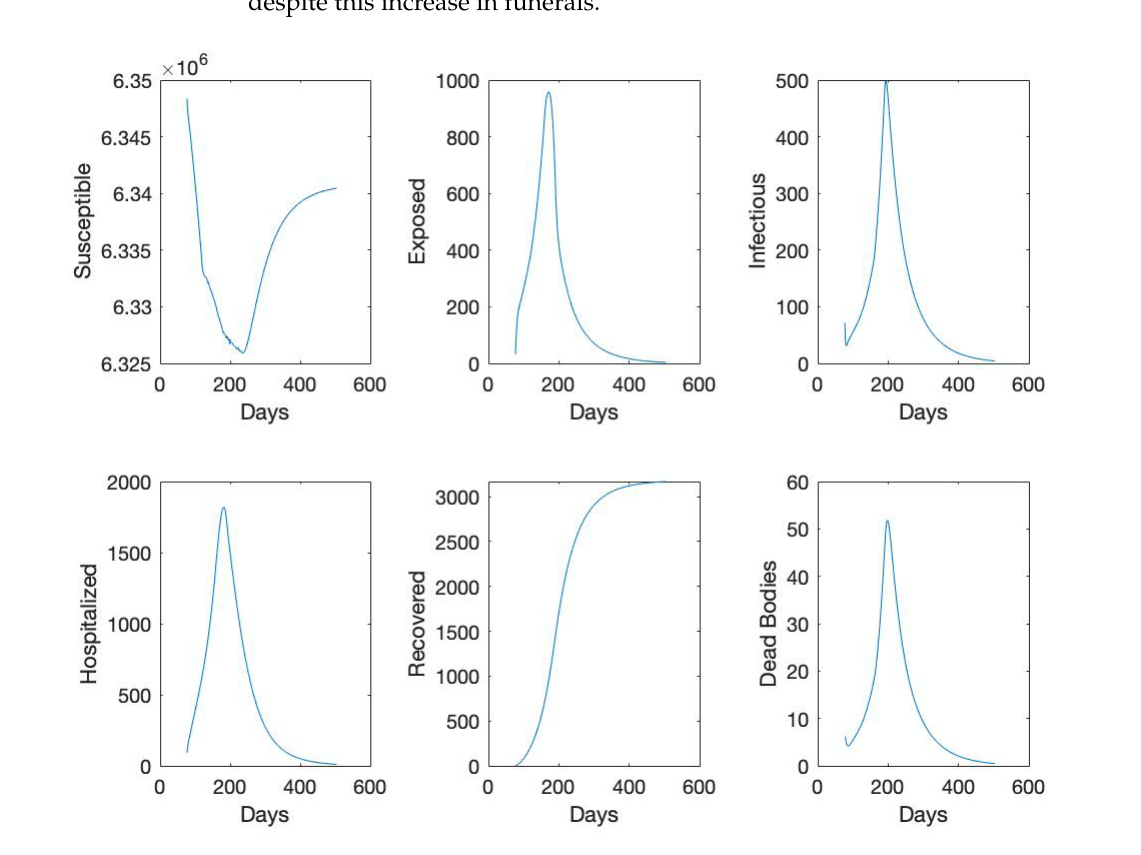
Figure 4. The graphs above correspond to the parameters from Table 2 and the data simulations from Figure 2. Note that the scales are all